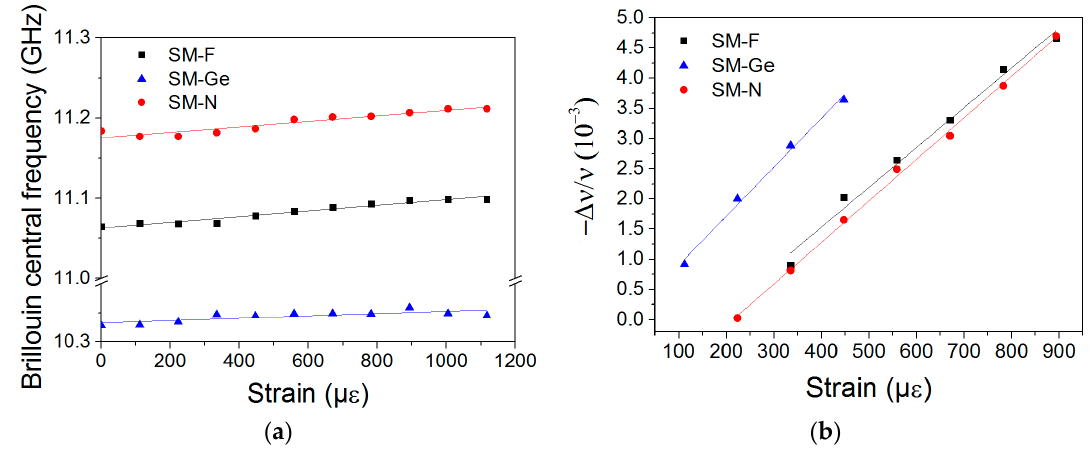
Figure 4. ( a ) Brillouin central frequency; and ( b ) Rayleigh relative spectral shift, as a function of the applied strain for SM-F (black square), SM-Ge (blue triangle) and SM-N (red circle) samples.